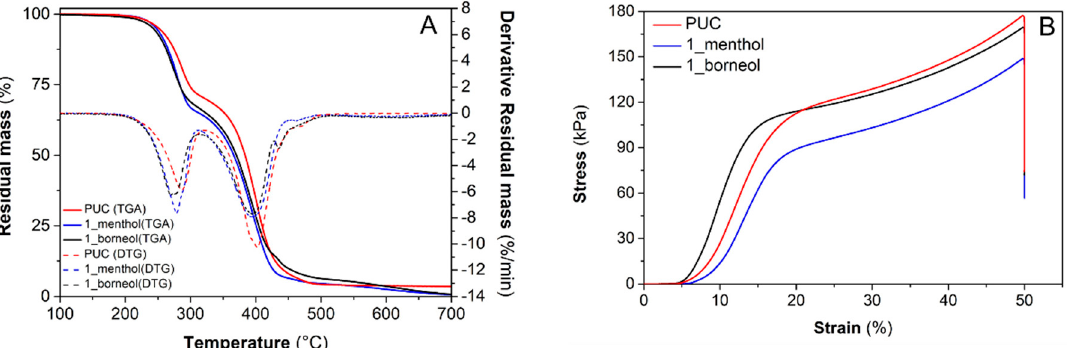
Figure 2. TGA-DTG thermograms ( A ) and stress–strain curves ( B ) of PUC, 1_menthol and 1_borneol foams. neol foams.